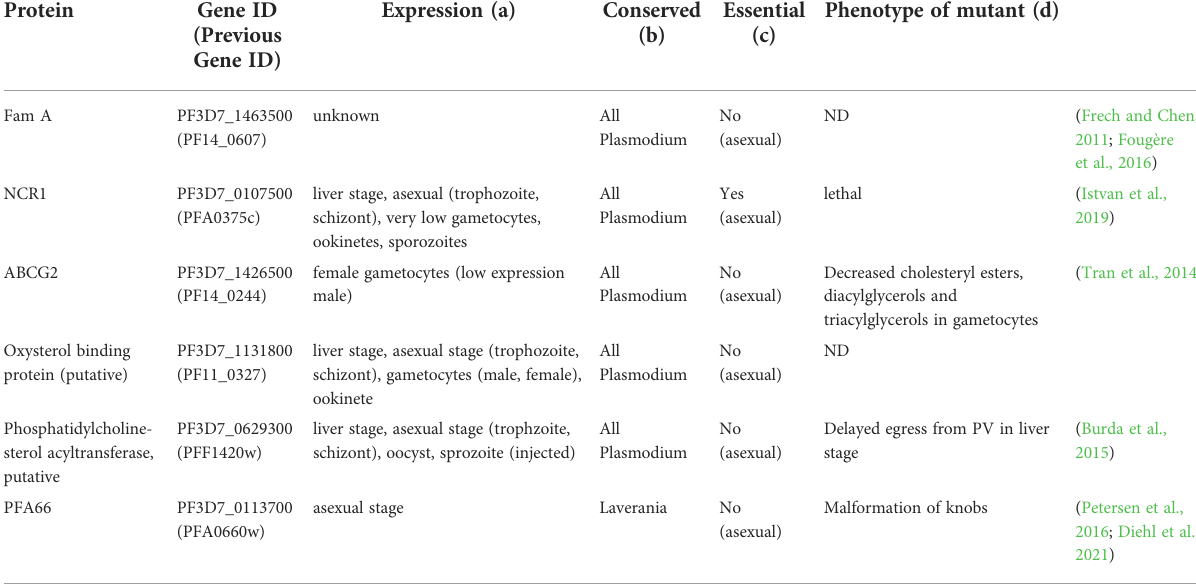
TABLE 1 Putative cholesterol binding proteins of Plasmodium